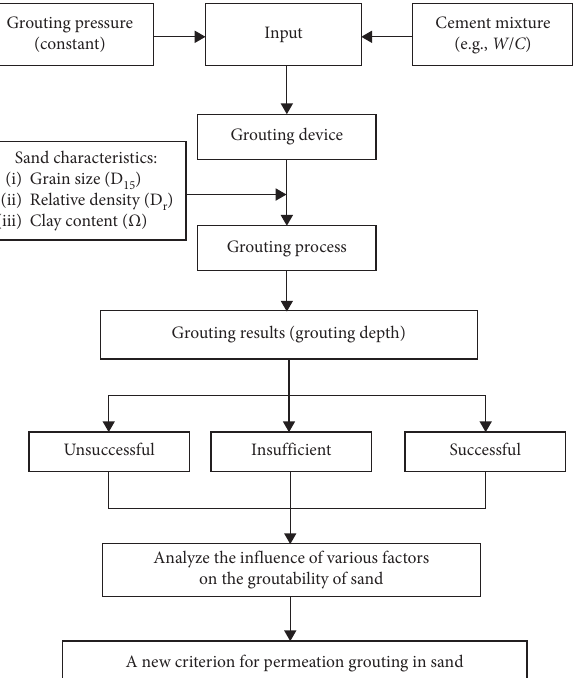
Figure 4: Flowchart of the overall